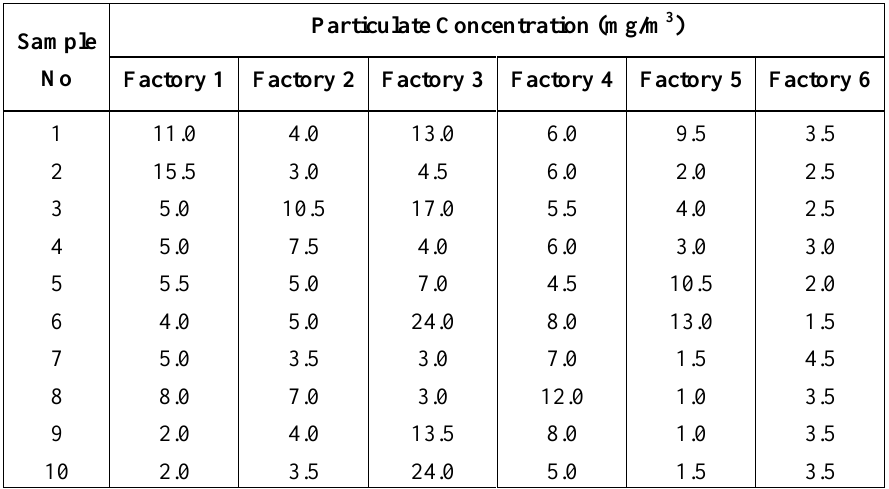
Table 2. Eight- hour Average Particulate Concentrations of Welding